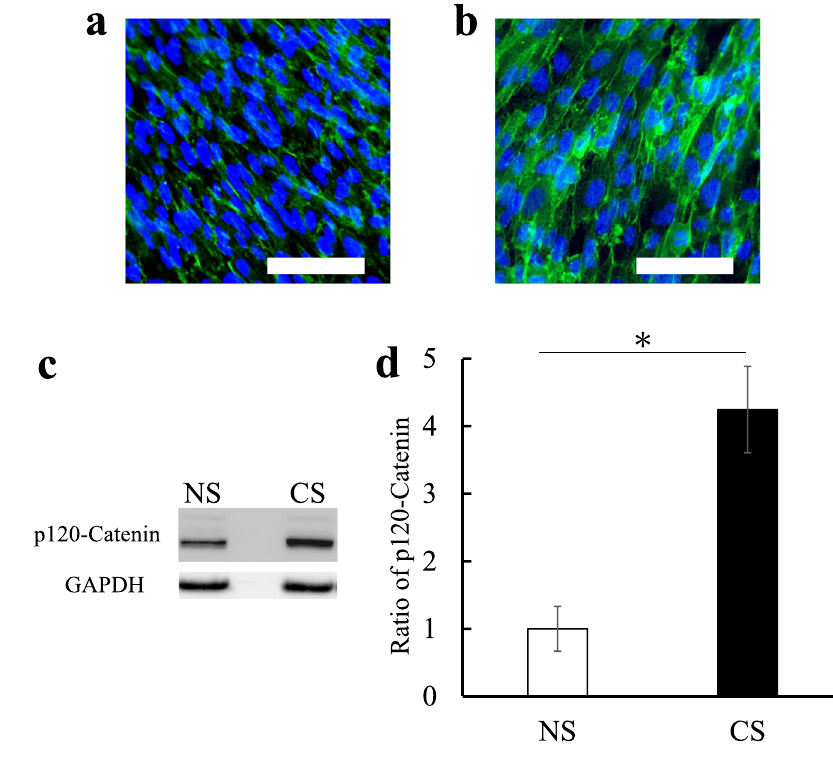
Fig. 2 Immuno fl uorescence images ( a ) and ( b ) and Western blot results ( c ) and ( d ) of p120- catenin for cell sheets cultured under NS and CS conditions, ( a ) for NS and ( b ) for CS, where p120-Catenin is visualized in green, nuclei in blue. Scale bar:100 μm. In ( d ), the ratio of p120-Catenin is quanti fi ed by the Western blot with an anti- p120-Catenin antibody. N = 4. Results are shown as means ± SE, * p < 0.05 ( c ). NS no strain, CS cyclic